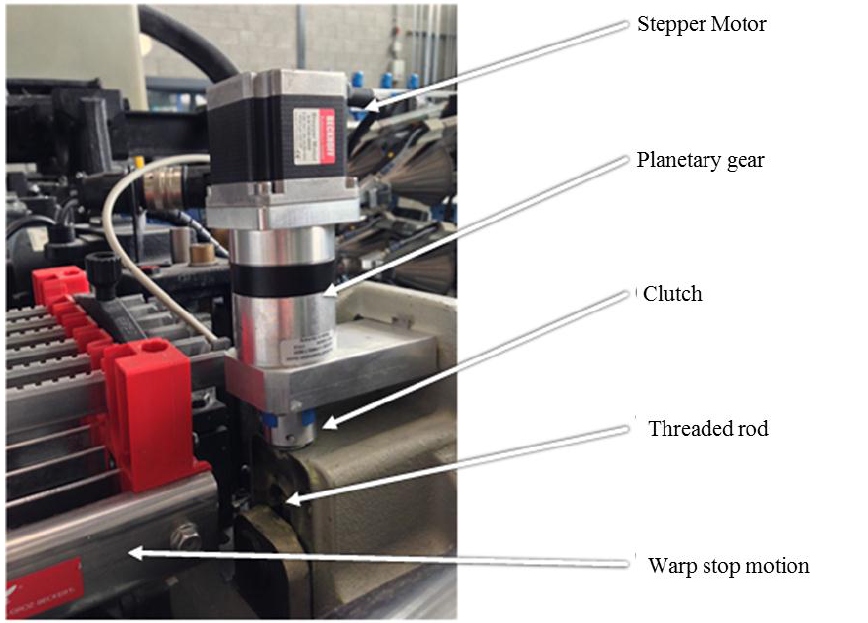
Figure 6. Mounted drive train on the weaving machine OMNIplus 800 by Picanol NV, Ieper,